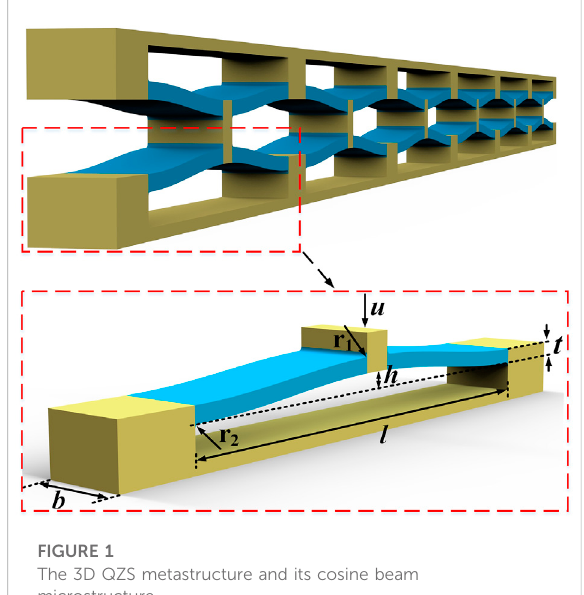
FIGURE 1 The 3D QZS metastructure and its cosine beam